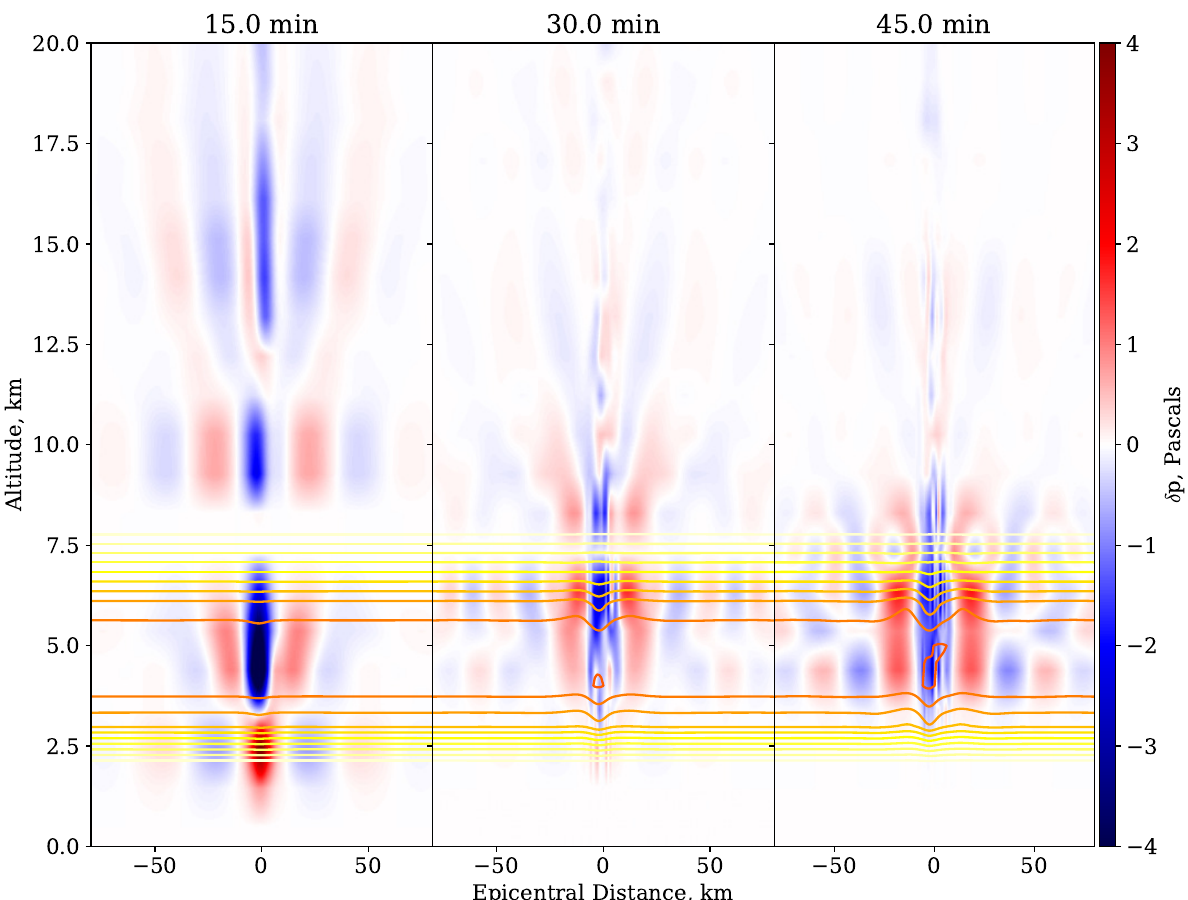
Figure 7. It presents snapshots of spatial distribution of CTDs as pixmaps and growth rate of CI as contours for the Unstable GWs+CI case. The growth rate increases from yellow to red